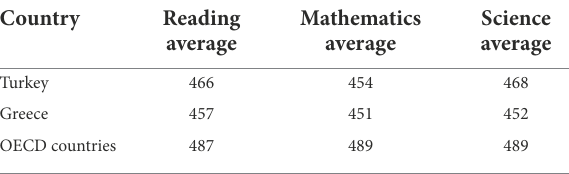
TABLE 1 2018 PISA exam results for Turkey and Greece * . Country Reading Mathematics Science average average